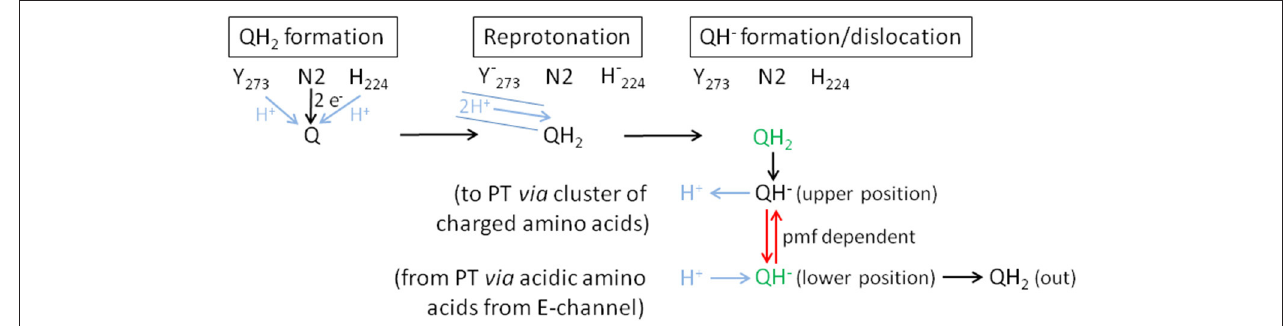
FIGURE 9 | Proposed mechanism of coupling electron transfer with proton translocation in complex I. Proton transfer reactions are shown in blue, the pmf-dependent dislocation of the quinol anion in the Q cavity in red and the positions that are blocked by piericidin A in green. Q is fully reduced close to Fe/S cluster N2 and protonated by Tyr273 CD and His224 CD (QH 2 formation). This position (green) is partly blocked by piericidin A. The recently discovered proton pathway in Yarrowia lipolytica complex I (Grba and Hirst, 2020) is indicated by the blue solid lines (Reprotonation). The 2 protons indicated in the pathway are either used to re-protonate the reactive amino acids or the quinone directly. Formation of QH 2 leads to its minor movement to the cluster of charged amino acids (Sharma et al., 2015) caused by breaking the hydrogen bond between H224 CD and D325 CD (QH − formation/dislocation). At the cluster of charged amino acids (upper position) QH 2 is deprotonated to the QH − anion and the proton enters the membrane to initiate proton translocation (PT) according to the proposed mechanism ( Kaila, 2018). To finish proton translocation the surplus proton is taken up by the QH − anion that is displaced to the lower position. This position (green) is also blocked by piericidin A. The displacement of the QH − anion is the energy releasing step. In the reverse reaction, the QH − anion needs the pmf to be placed at the upper position. In the absence of the pmf, as in our experiments, the QH − anion stays at the lower position and is therefore detectable by UV-vis